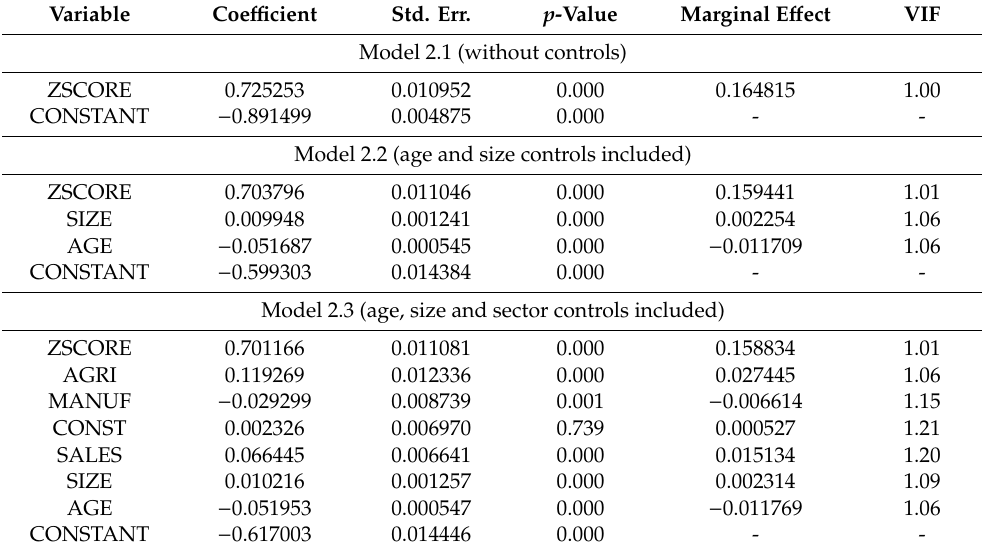
Table 4. Three logistic regression models with bankruptcy risk as independent variable (dependent variable